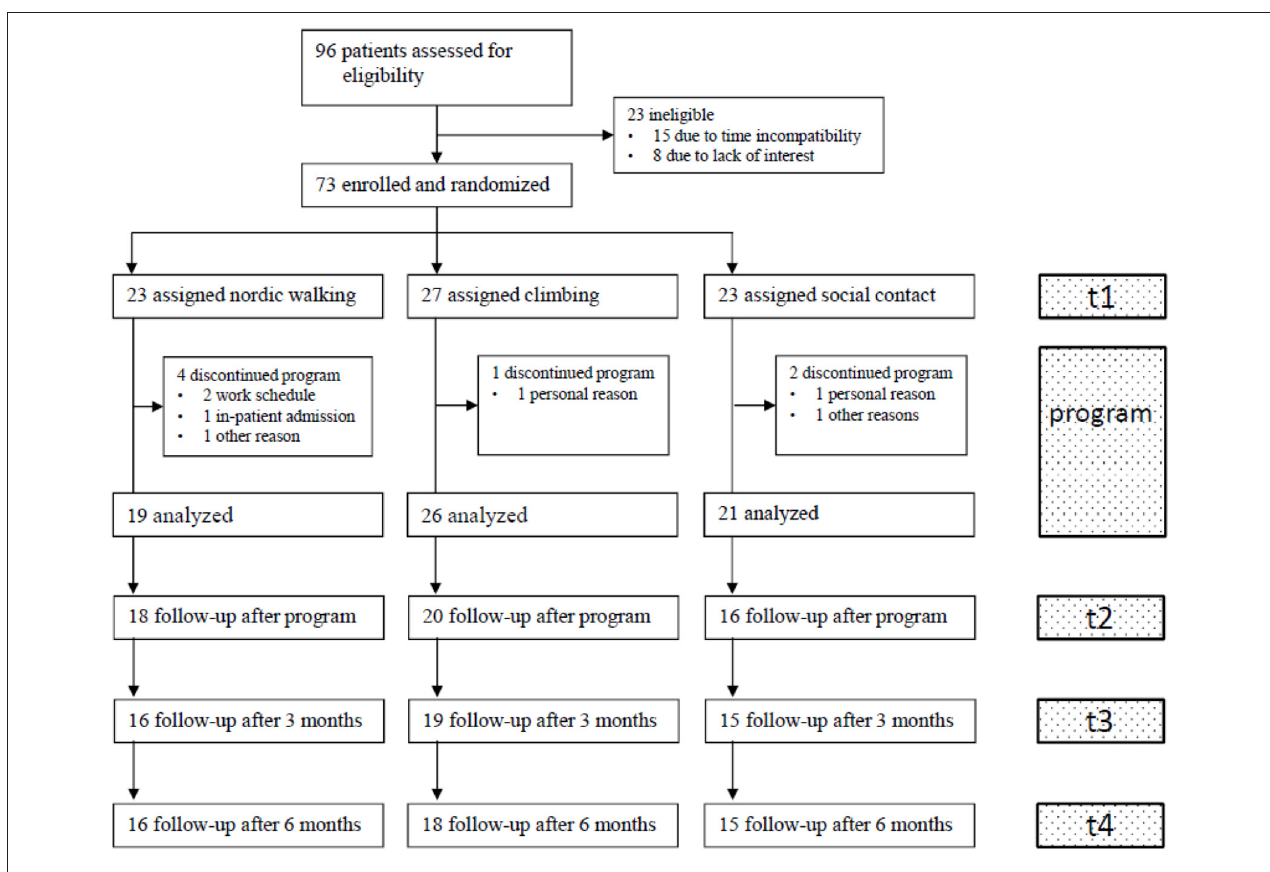
FIGURE 2 | Participant